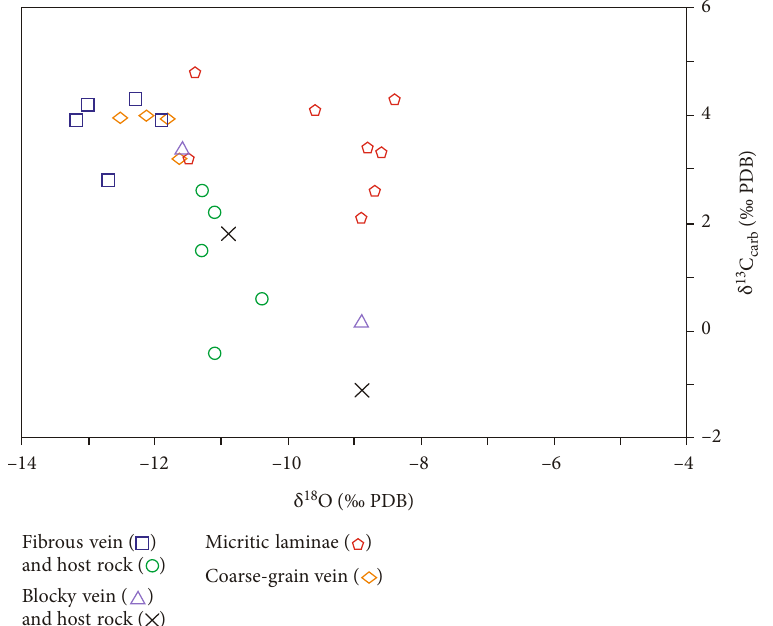
Figure 12: C-O isotopes of micritic laminae, calcite veins, and adjacent host rocks. The data of the coarse-grained vein are from Liu et al. [49].